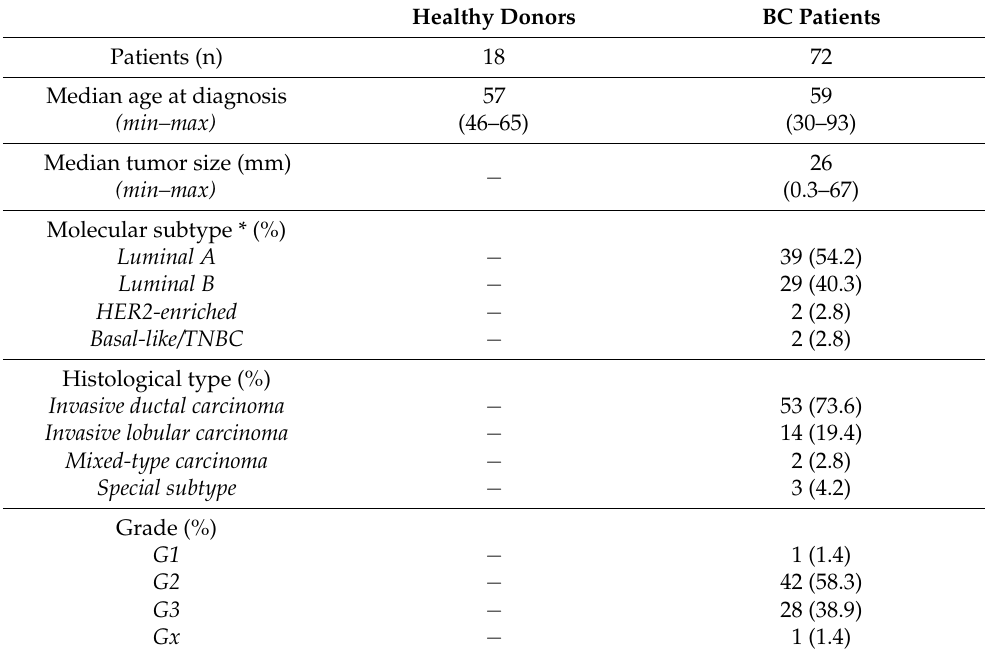
Table 1. Detailed clinicopathological data of the BC patients and healthy